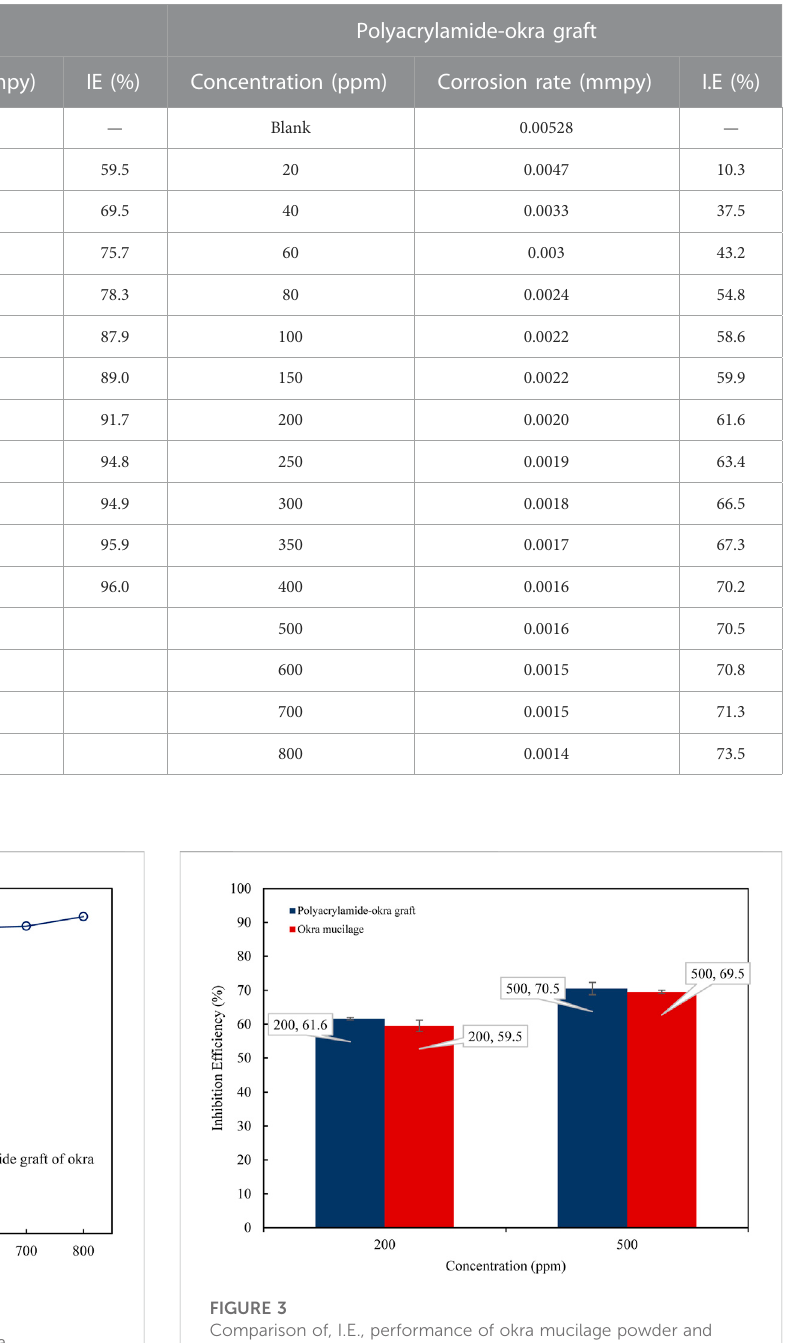
TABLE 1 Weight loss analysis for mild steel with different concentrations of okra mucilage and polyacrylamide-okra graft extracts at 25 ° C for 24 h.